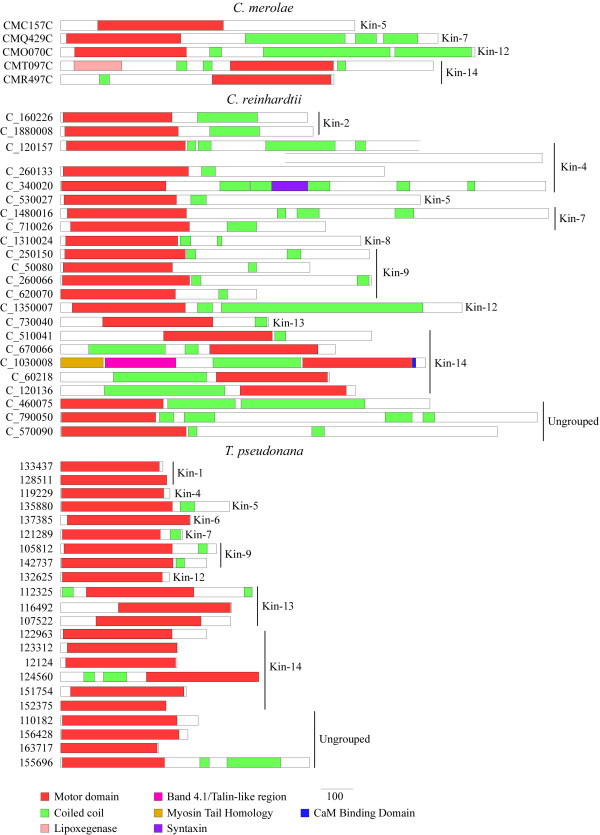
Domain schematics for unicellular photosynthetic eukaryotes. Schematic diagrams showing the domain architecture of kinesins in C. merolae, C. reinhardtii and T. pseudonana. Family classifications are shown to the right of the proteins.